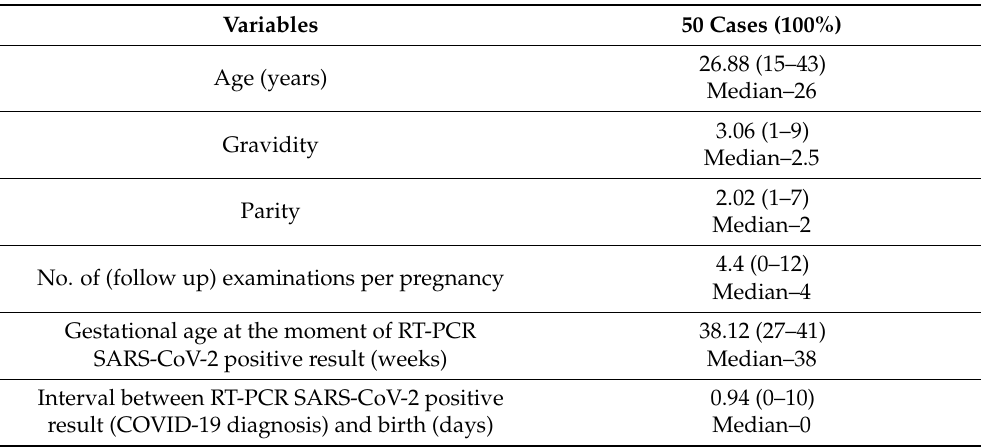
Table 1. Maternal